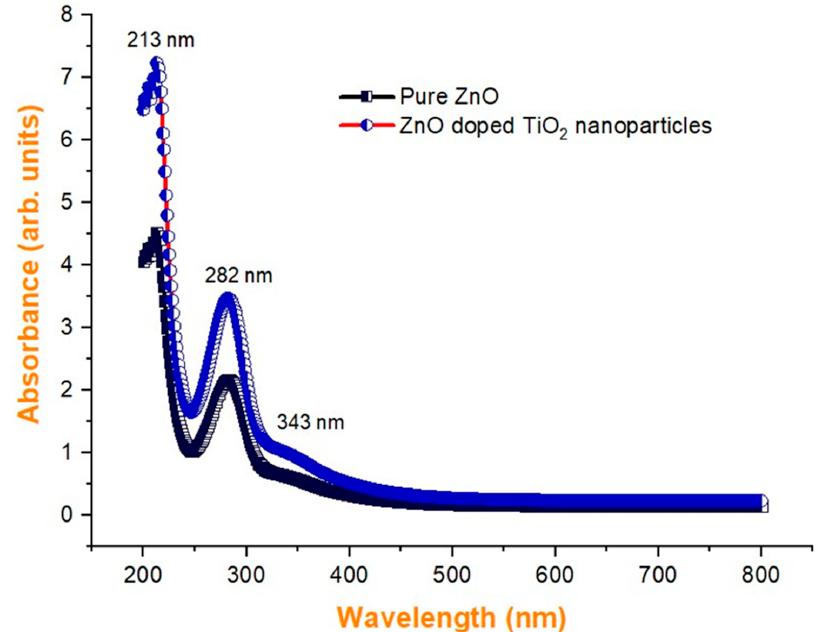
Figure 4. UV-visible spectrum of synthesized pure ZnO and ZnO-doped TiO 2 nanocomposites.